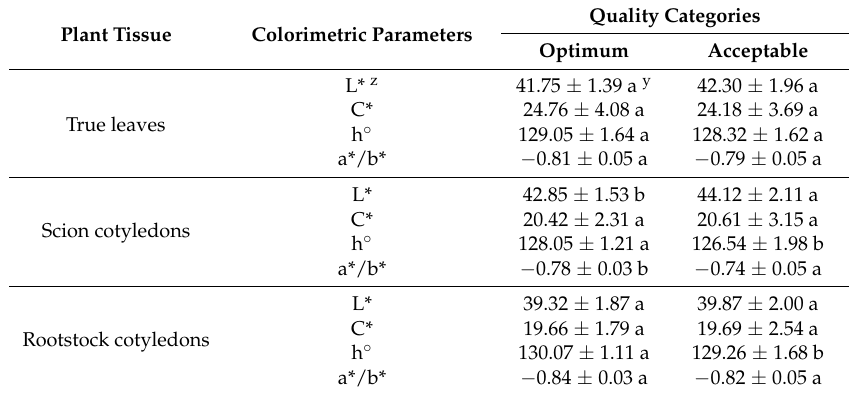
Table 3. Colorimetric parameters of grafted watermelon seedlings from two quality categories 7 days after